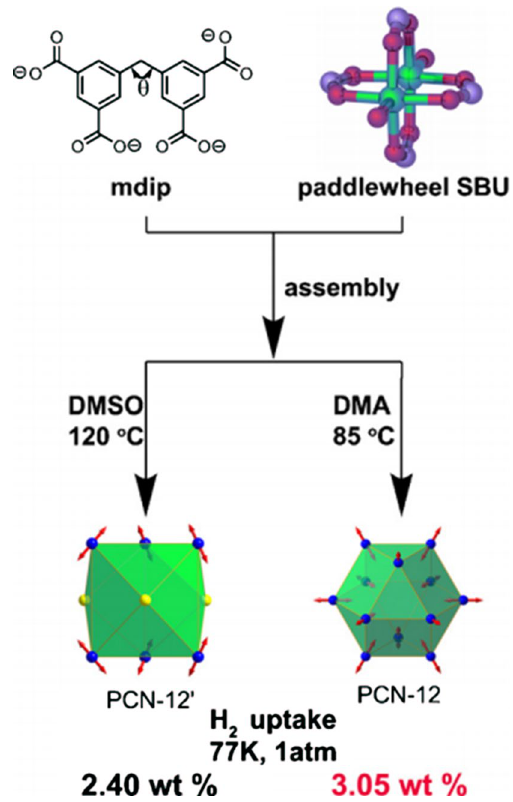
Fig. 2 Synthesis, UMCs alignment, and hydrogen uptake of two MOF poly-morphs: PCN-12 and PCN-12 ′ (Adapted from Kuppler et al.